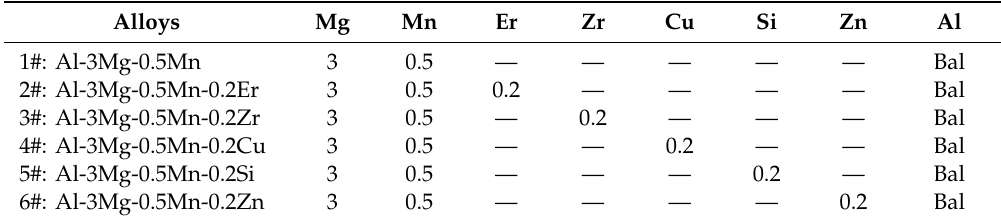
Table 1. Nominal chemical compositions of studied alloys